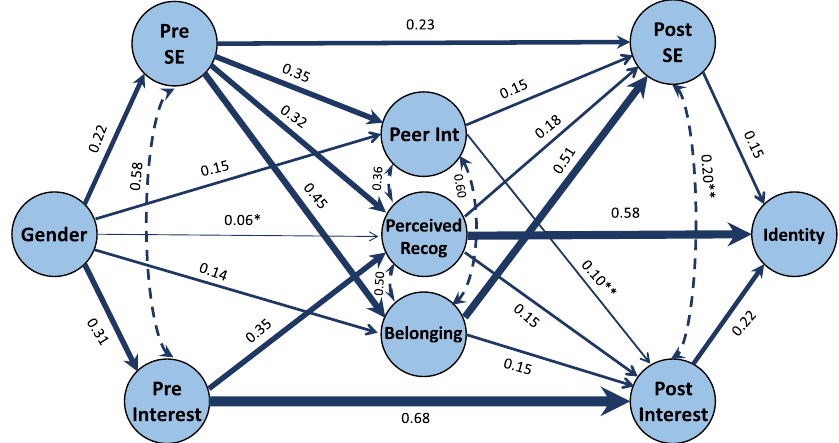
FIG. 5. Schematic diagram of the path analysis part of the structural equation modeling between gender and being a physics person through self-efficacy, interest, perceived recognition, peer interaction, and sense of belonging. The solid lines represent regression paths, and the dashed lines represent residual covariances. The regression line thickness corresponds to the magnitude of the β value (standardized regression coefficient) with 0 . 01 < p < 0 . 05 indicated by * and 0 . 001 < p < 0 . 01 indicated by **. Other regression lines show relations with p < 0 . 001